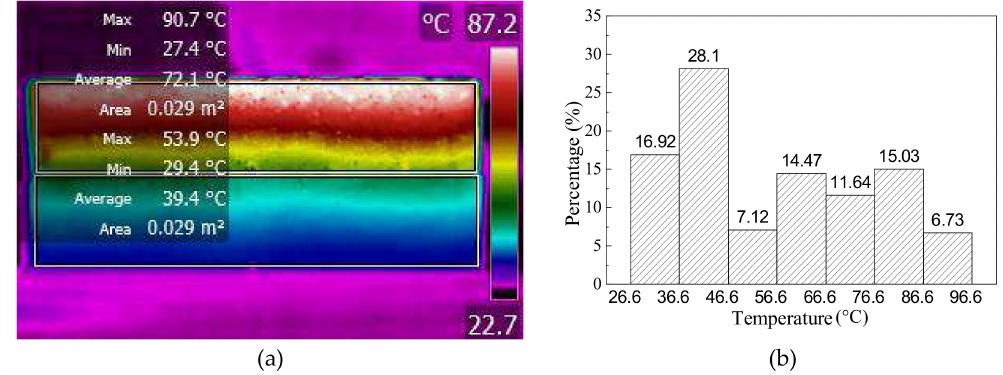
Figure 6. The ( a ) infrared image and ( b ) temperature distribution of the beam sample with 60 s induction